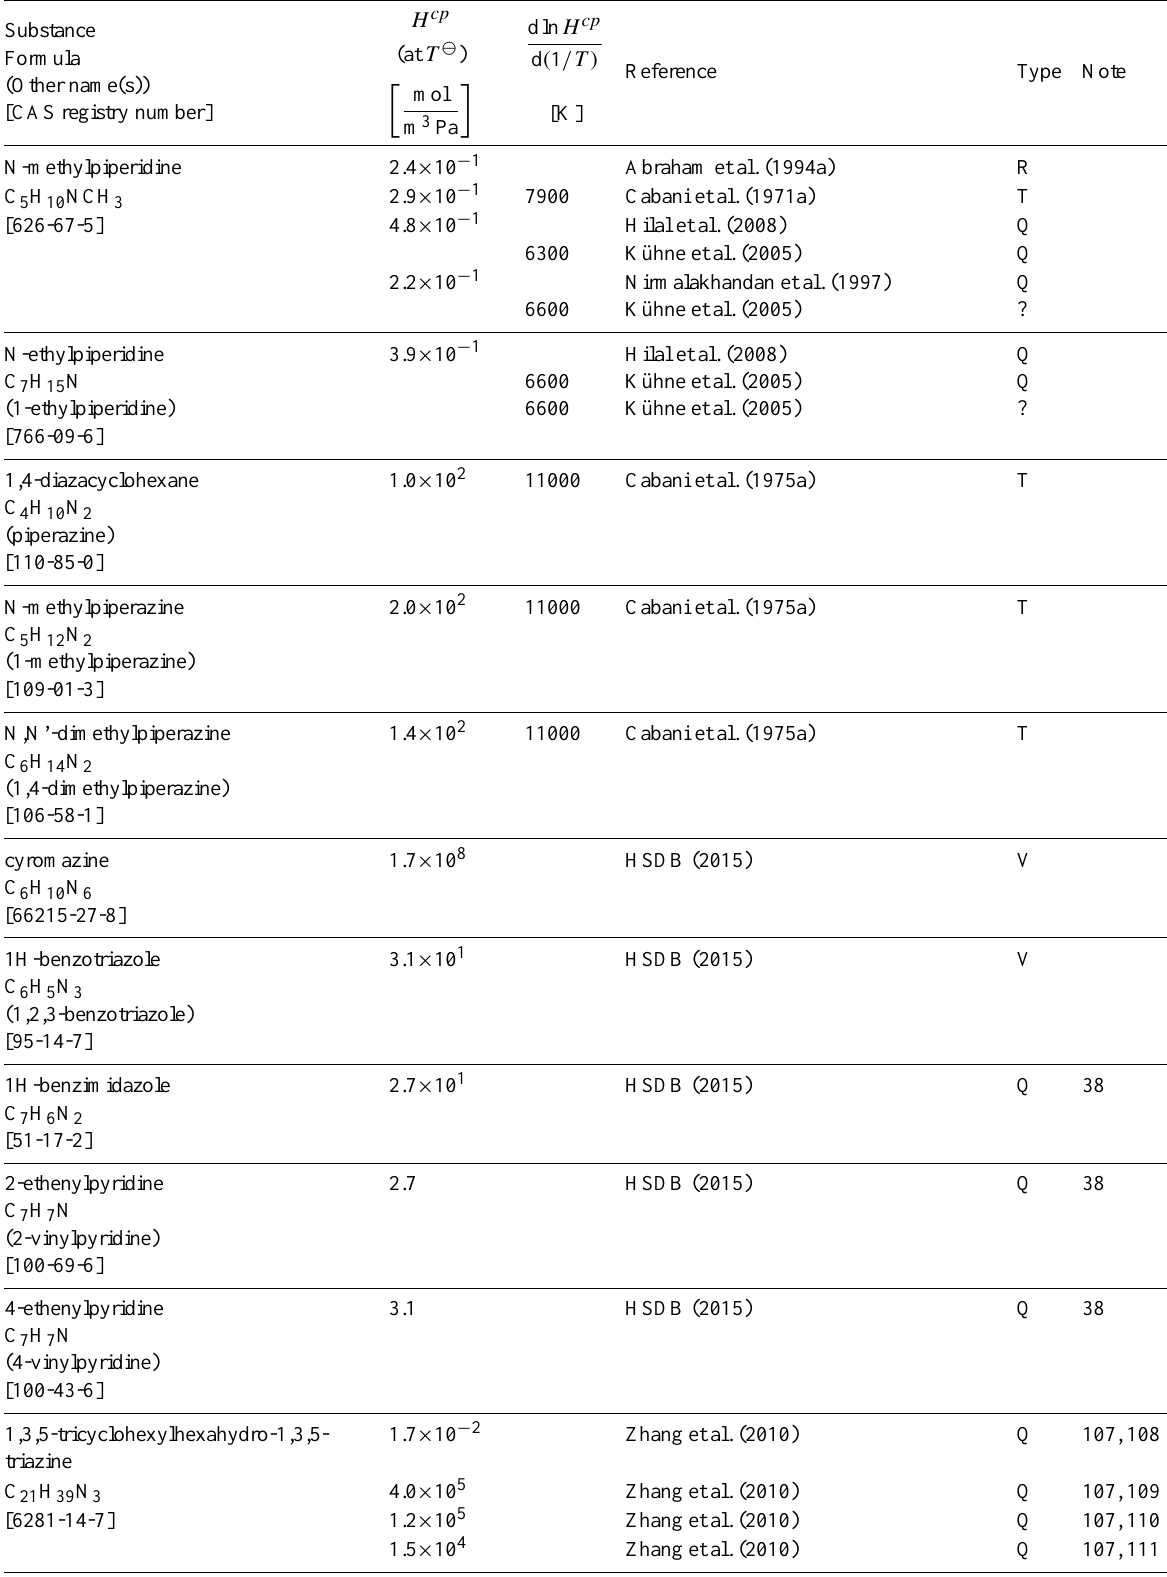
Table 6: Henry’s law constants for water as solvent